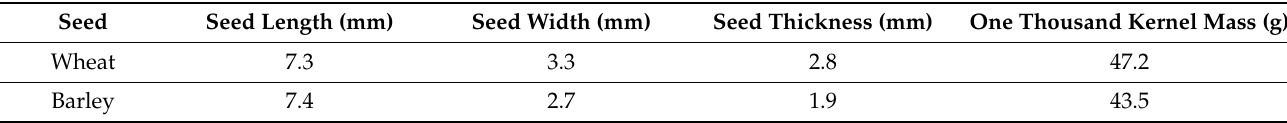
Figure 2. The seed drill to which the developed helicoidal seed tube was mounted during the eval- Table 2. The main dimensions of wheat and barley seeds used in the uation. Table 2. The main dimensions of wheat and barley seeds used in the study.